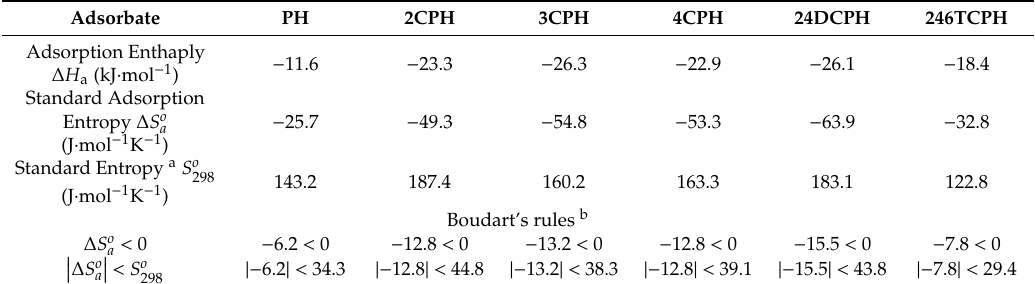
Table 7. Verification of adsorption enthalpy for phenol, 2-chlorophenol, 3-chlorophenol, 4-chlorophenol, 2-, 4-dichlorophenol, 2-, 4-, 6-trichlorophenol on HDTMA / HAL adsorbent using Boudart’s